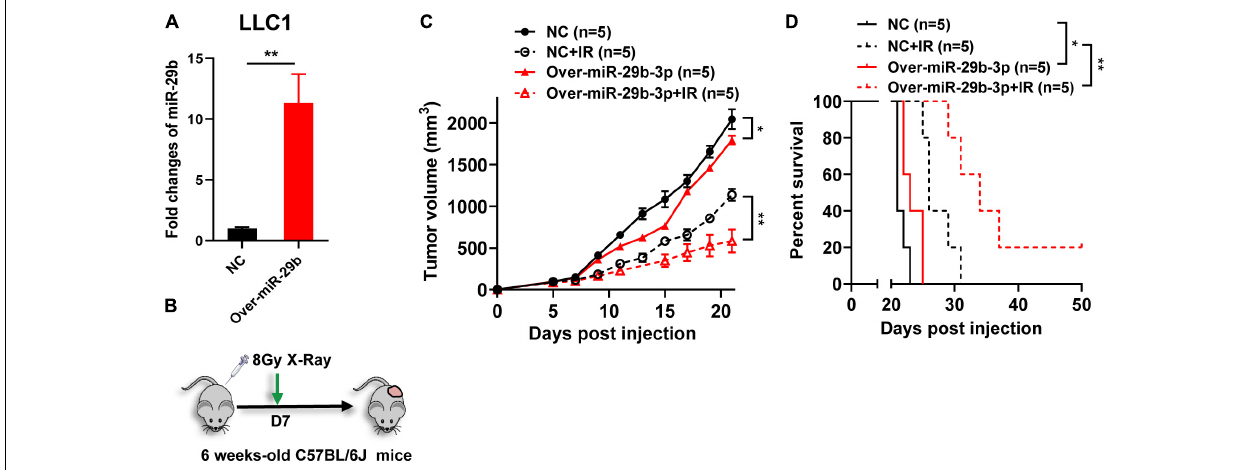
FIGURE 5 | The miR-29b-3p expression level on the efficacy of radiotherapy in vivo . (A) Relative expression of miR-29b-3p measured by qRT-PCR in miR-29b-3p overexpressed LLC1 cells. (B) Protocol for radiation treatment. (C,D) Tumor growth and Kaplan–Meier survival curves of C57BL/6 mice inoculated with 2 × 105 VC or miR-29b-3p overexpressed LLC1 cells. Radiotherapy was conducted lx at 8 Gy at 7 days post inoculation of the tumor cells. NC, negative control. Significance was determined by 2-way ANOVA in c, logrank test in d respectively. * P < 0.05; ** P <